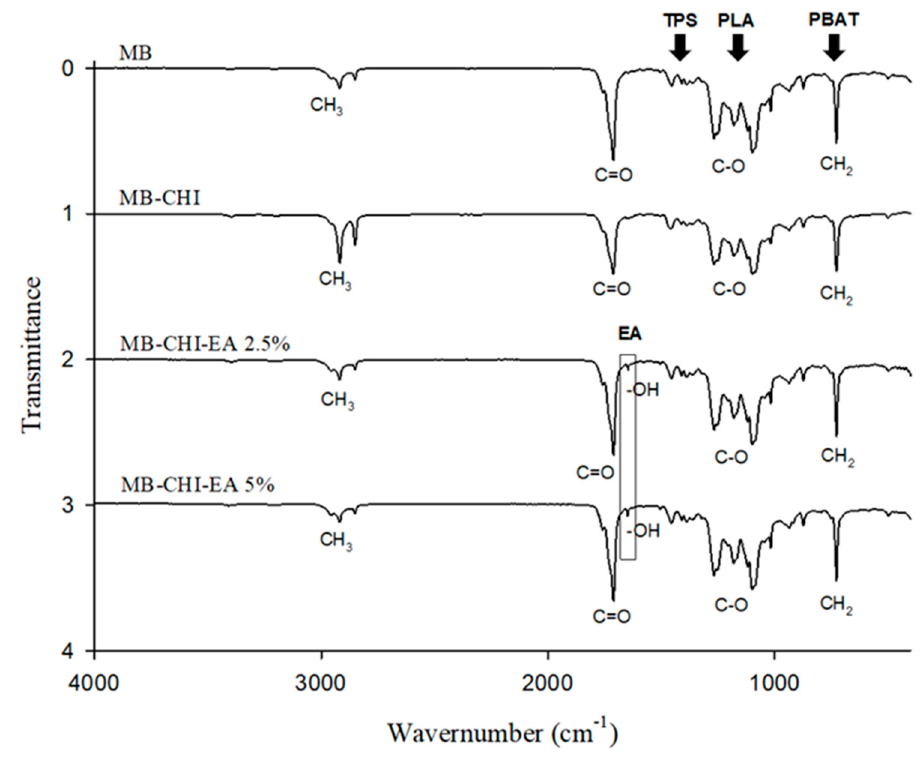
Figure 2. IR spectra of the biopolymers and active coating biopolymers.